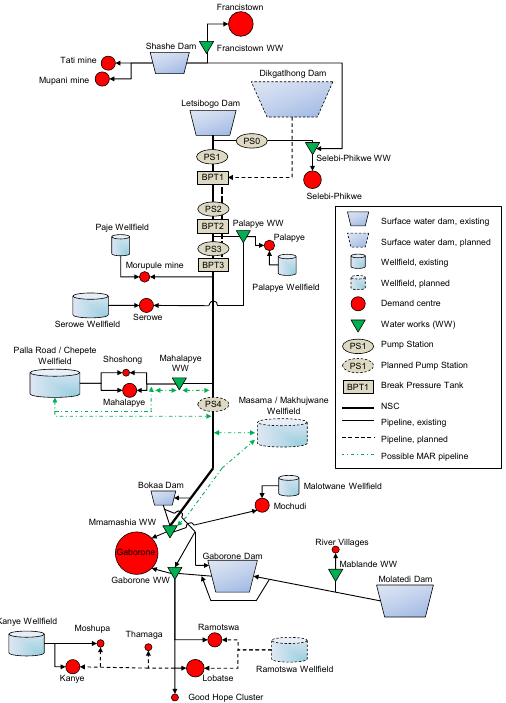
Figure 1. Schematic illustration of the water supply system linked to the North–South Carrier (NSC), according to the situation when the study was performed in the year 2013.